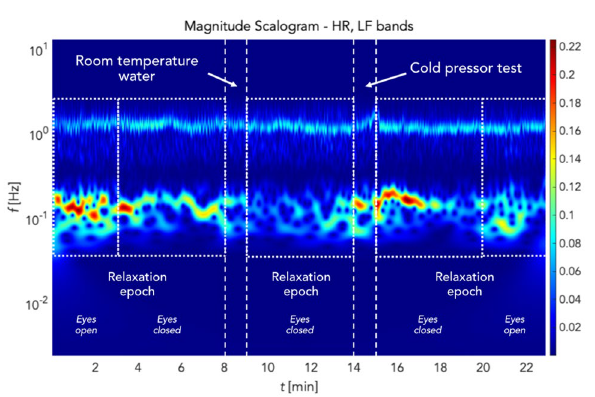
Figure 8. Filtered scalogram showing heart rate (HR) and low frequency (LF) bands and experimental